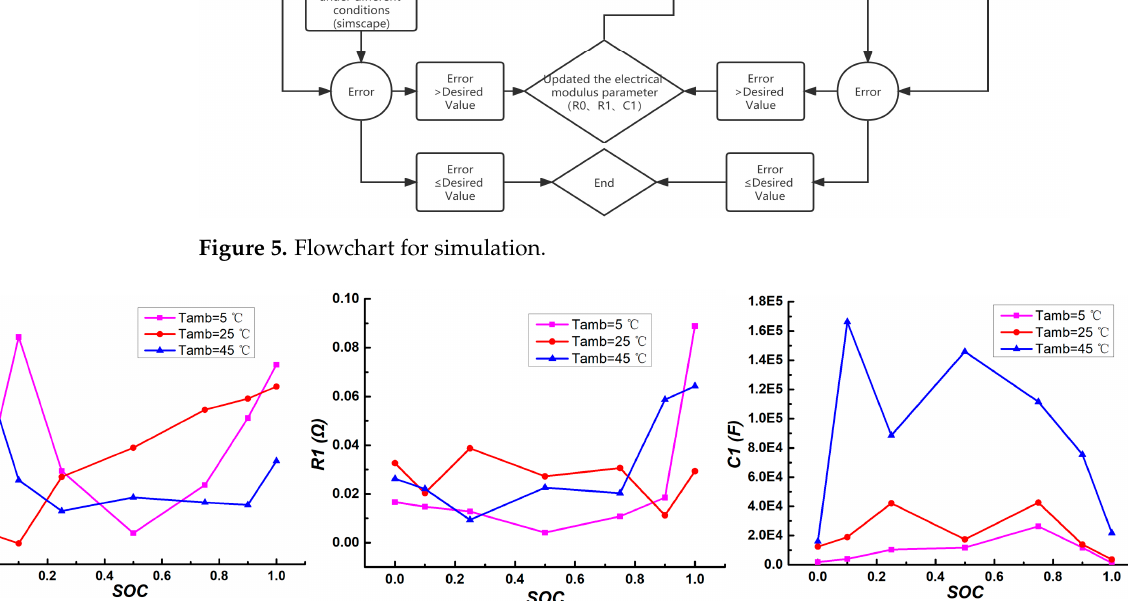
Figure 6. ( a ) Changes of R0 with SOC and ambient temperature; ( b ) Variation of R1 with SOC and ambient temperature; ( c ) Changes of C1 with SOC and ambient temperature.